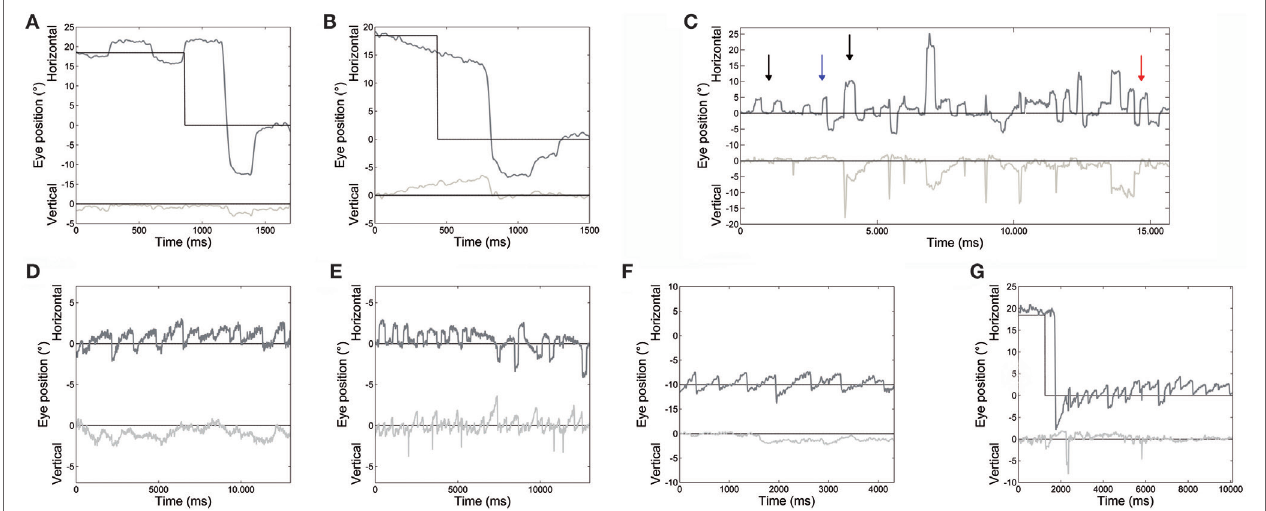
FigUre 2 | An example of different oculomotor abnormalities found in both patients. (a) Very large hypermetric saccade, with higher than normal speed and followed by corrective saccades to reach the target. (B) Slow drifts preceding a centripetal saccade. (c) Large square-wave saccadic intrusions: square-wave jerk, macrosquare-wave jerks (black arrows), biphasic square-wave saccadic intrusions (blue arrow); and macrosaccadic oscillations (red arrow). (D) Spontaneous jerk nystagmus with mainly horizontal and, sometimes, (e) vertical component appearing as an oblique nystagmus. (F) Gaze-evoked nystagmus in eccentric gaze positions of 10°, and rebound nystagmus (g) after the eye was returned to central position. Horizontal and vertical eye positions are plotted in different shades of gray. The black line shows horizontal and vertical target position. Positive values correspond to rightward and